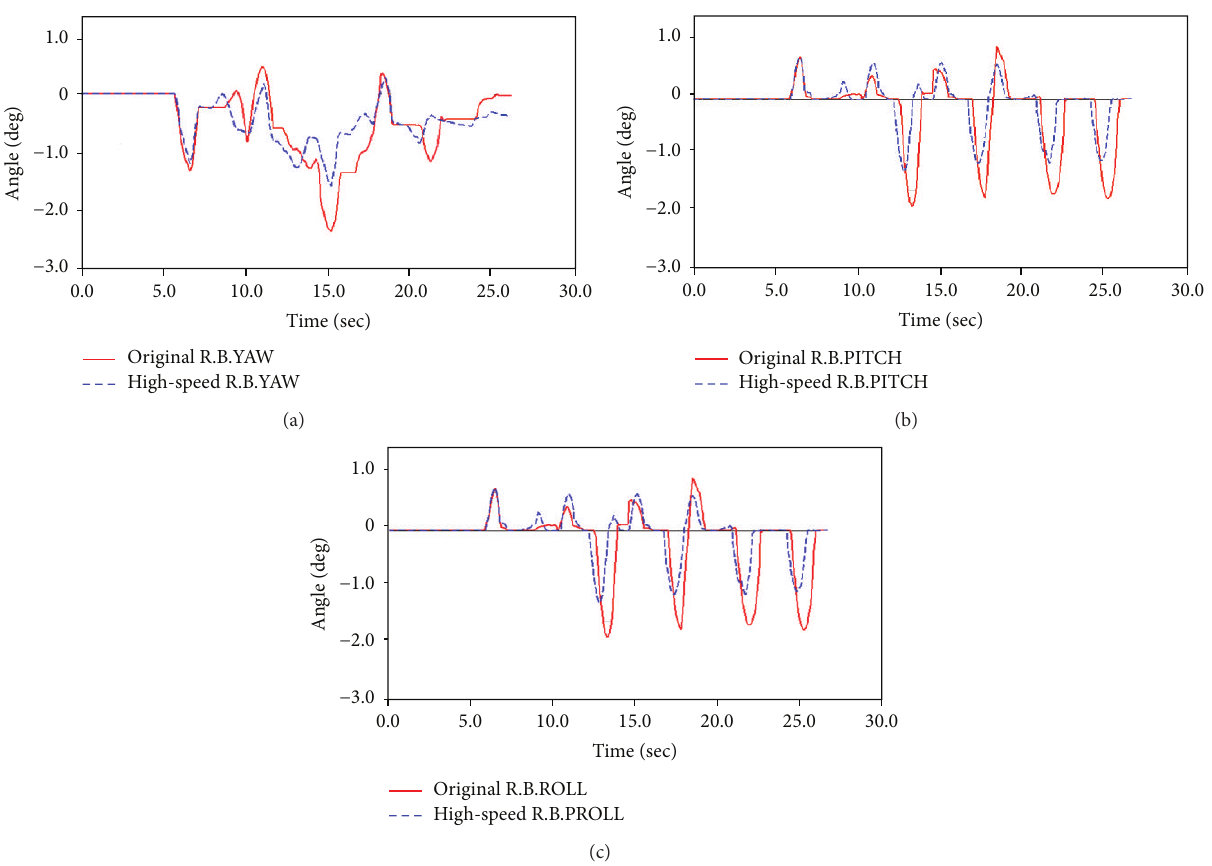
Figure 7: Yaw, pitch, and roll angular variation of the main body: (a) yaw angular variation of the main body, (b) pitch angular variation of the main body, and (c) roll angular variation of the main body.